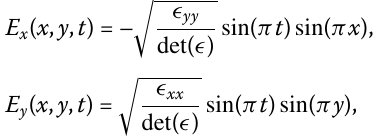
2 + y 2 + 1, (cid:3) xx = 4 x